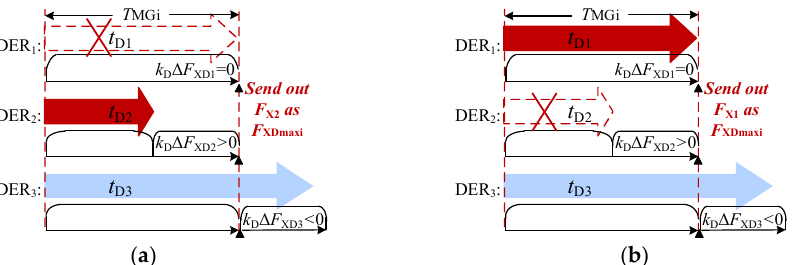
Figure 9. Influence of the DER outage to the 1st DL selection within individual MG under ( a ) the leader DER outage, ( b ) the non-leader DER outage.